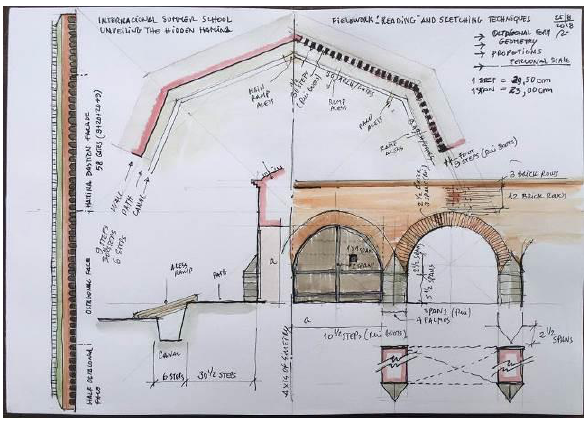
Figure 9. Representation of singular details and its basic measures, provided by student Rui